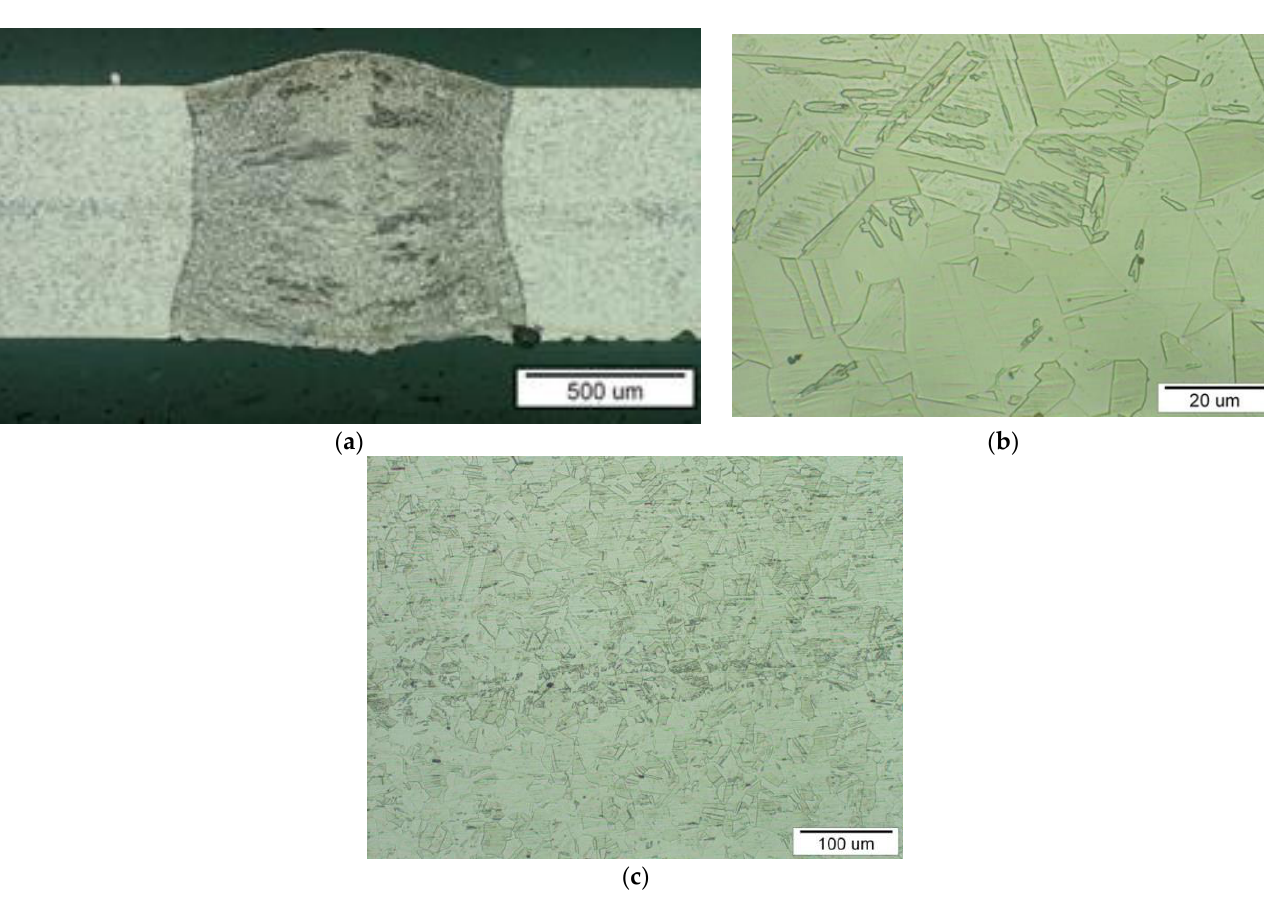
Figure 13. ( a ) Overall image of the AISI 304 welded-joint microstructure; ( b ) detail of AISI 304 welded-joint microstructure; ( c ) AISI 304 base material microstructure.